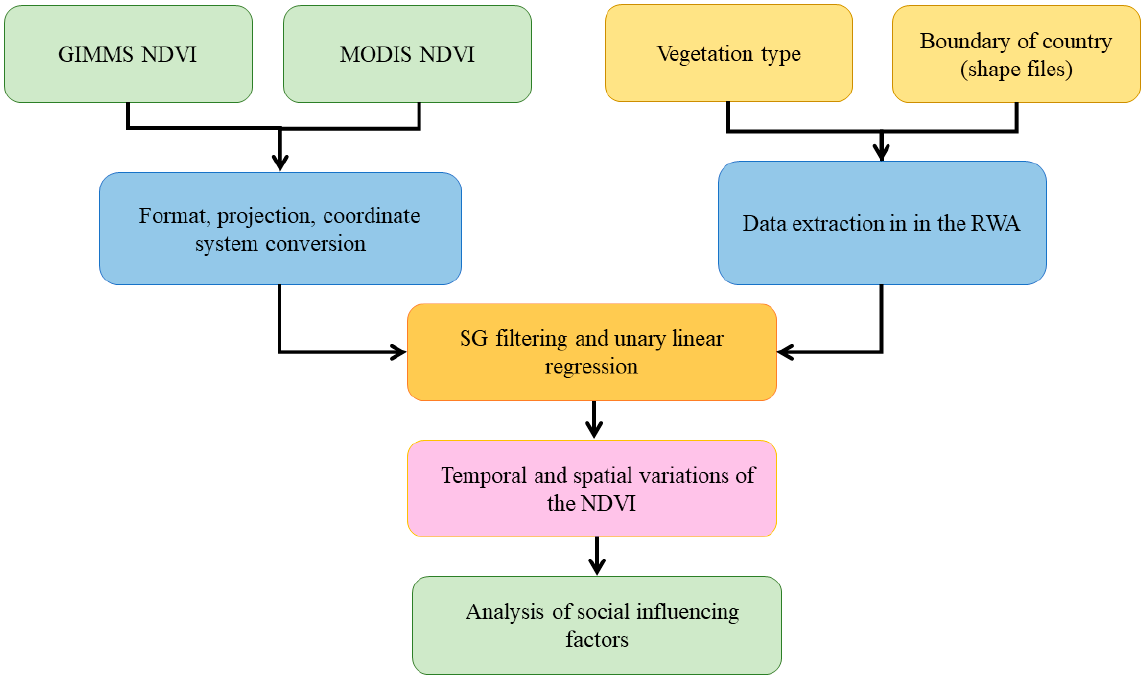
Figure 2. Workflow of data processing. GIMMS: Global Inventory Modeling and Mapping Studies; NDVI: normalized difference vegetation index; MODIS: Moderate-resolution Imaging Spectroradiometer; SG: Savitzky–Golay.